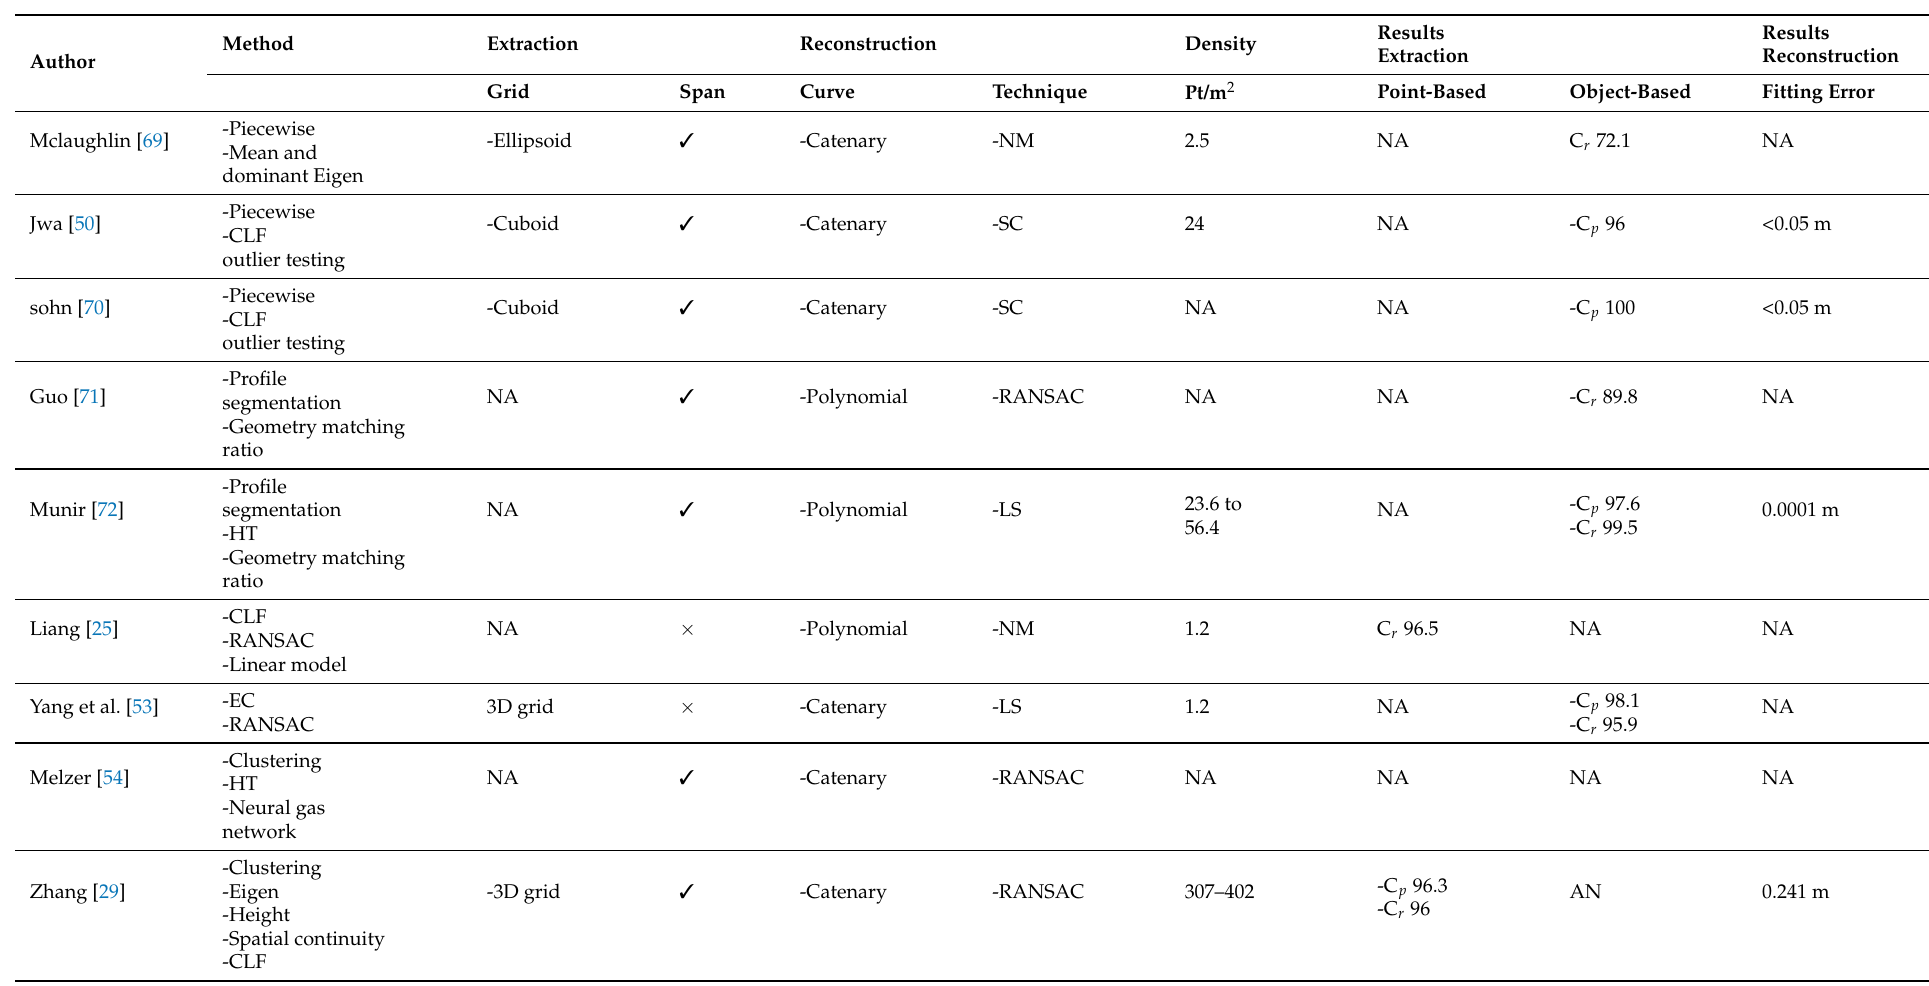
Table 3. Single power line extraction using ALS. LS—Least square; PL—Power line; HT—Hough transform; CLF—Compass line filter; EC—Euclidean clustering; NM—Numerical method; SC Stochastic constraints; NA—Not available; C p —Completeness; C r